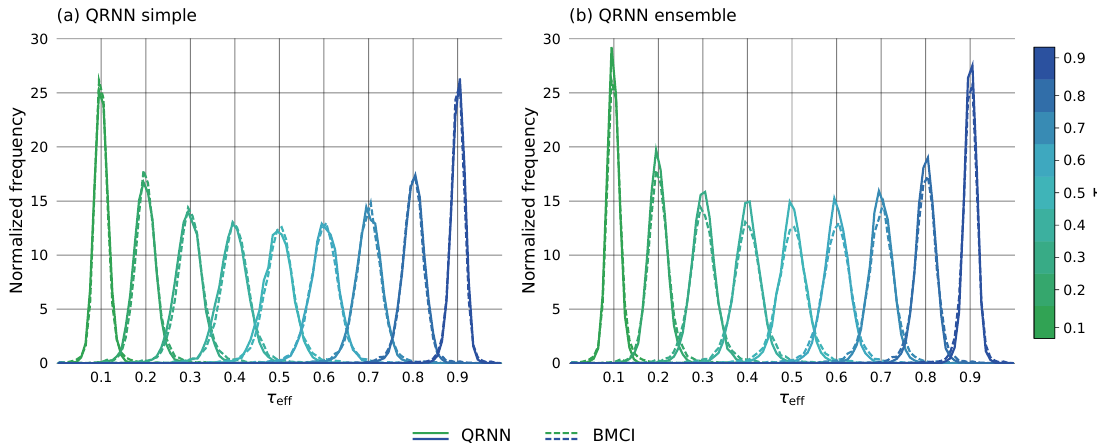
Figure 5. Distribution of effective quantile fractions τ eff achieved by QRNN and BMCI on the test data. Panel (a) displays the performance of a single QRNN compared to BMCI; panel (b) displays the performance of the